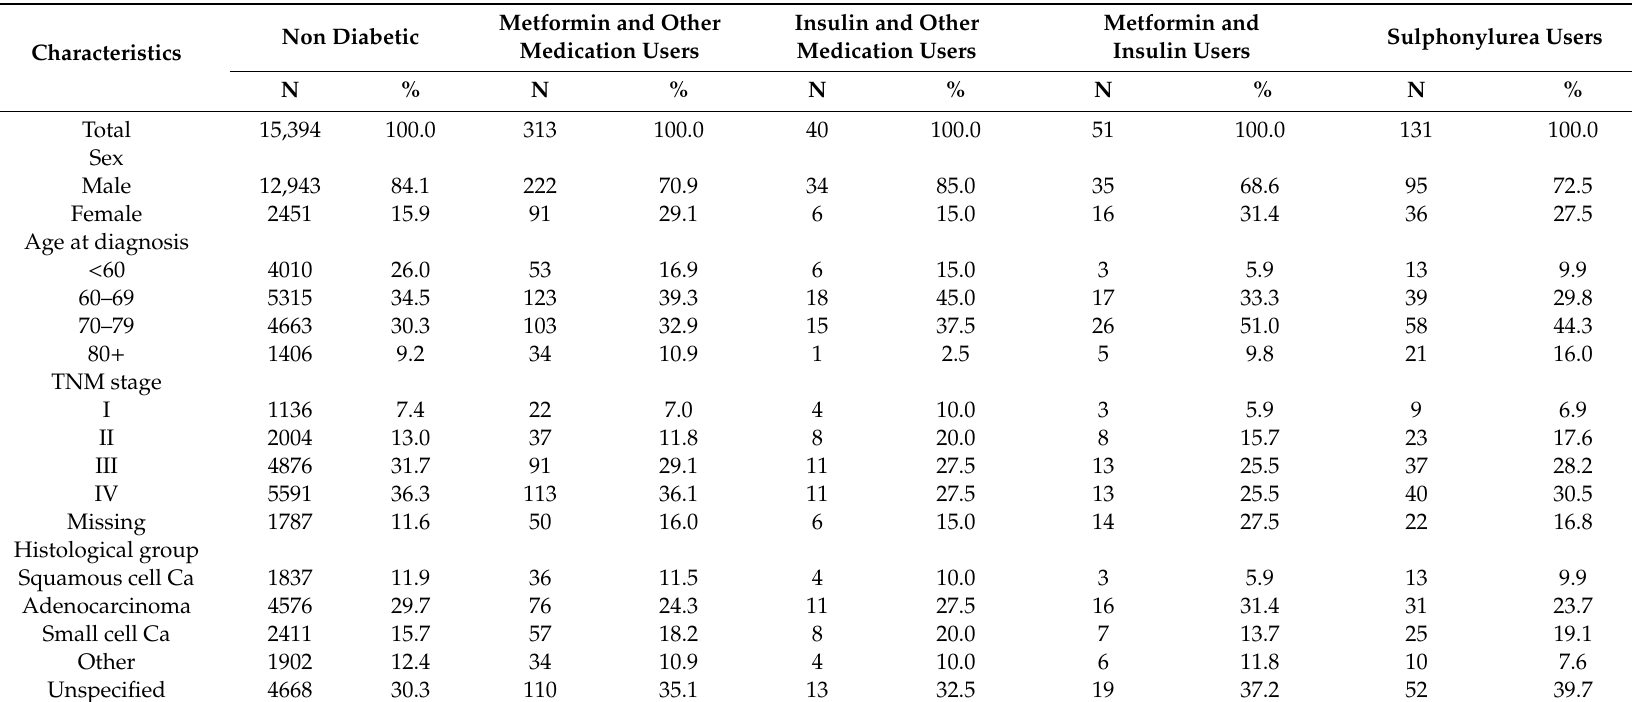
Table 1. Demographic and clinical characteristics of patients with lung cancer, by diabetes status and antihyperglycemic medication use.